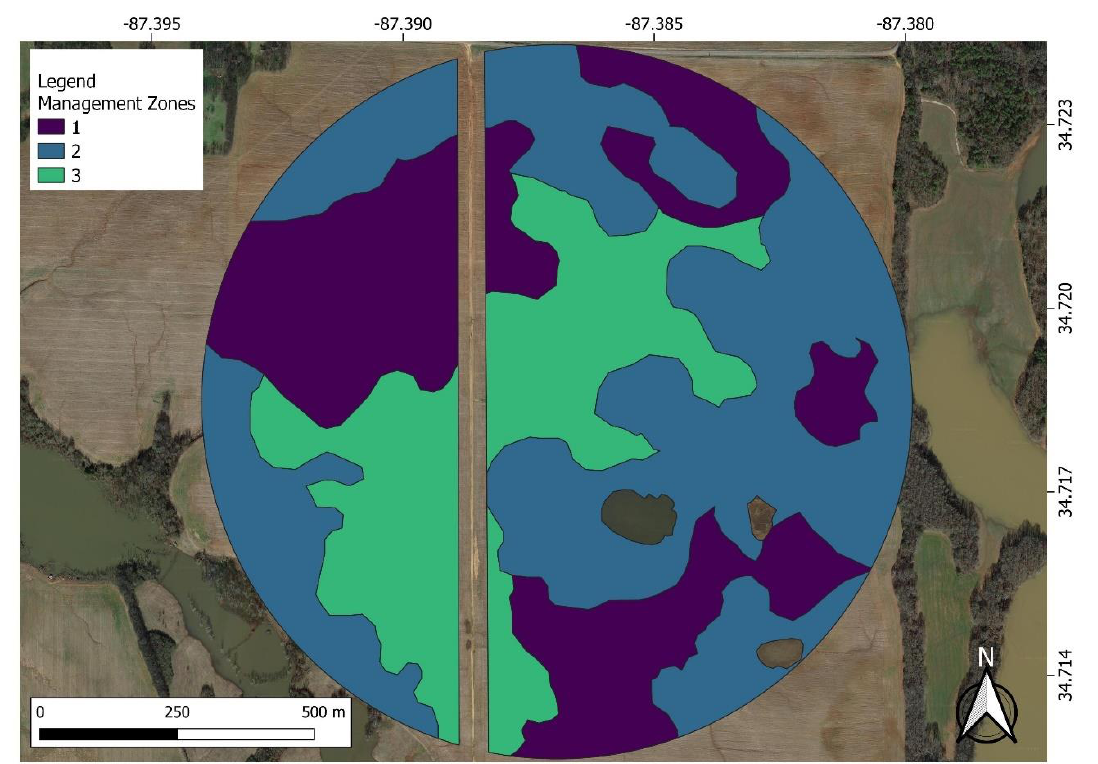
Table 3. Soil proprieties of the study field.